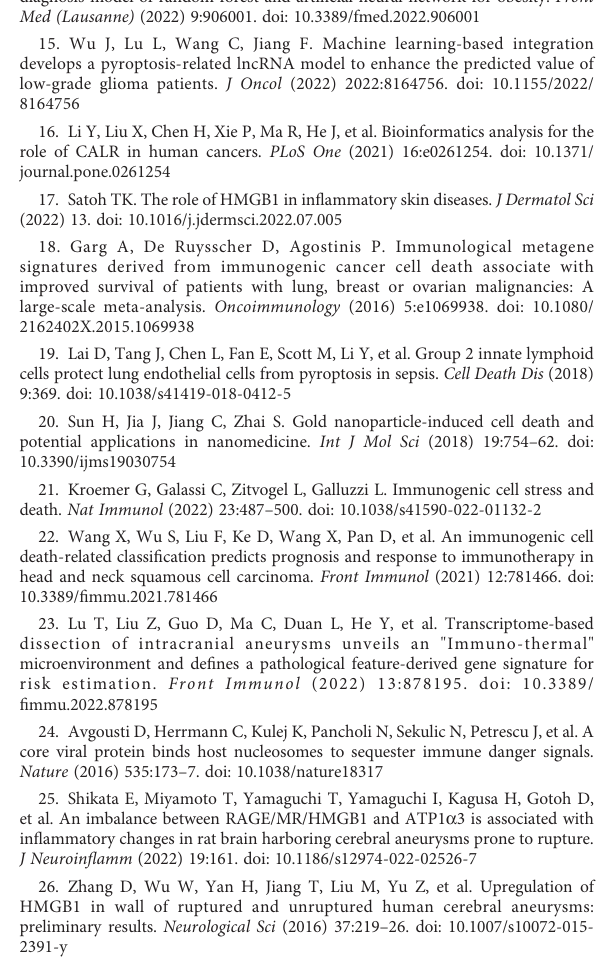
SUPPLEMENTARY FIGURE 3 (A) Variations in the expression levels of 13 immune response gene sets between IA and normal tissue samples. (B) Variations in the expression levels of 18 HLA genes between IA and the normal samples.